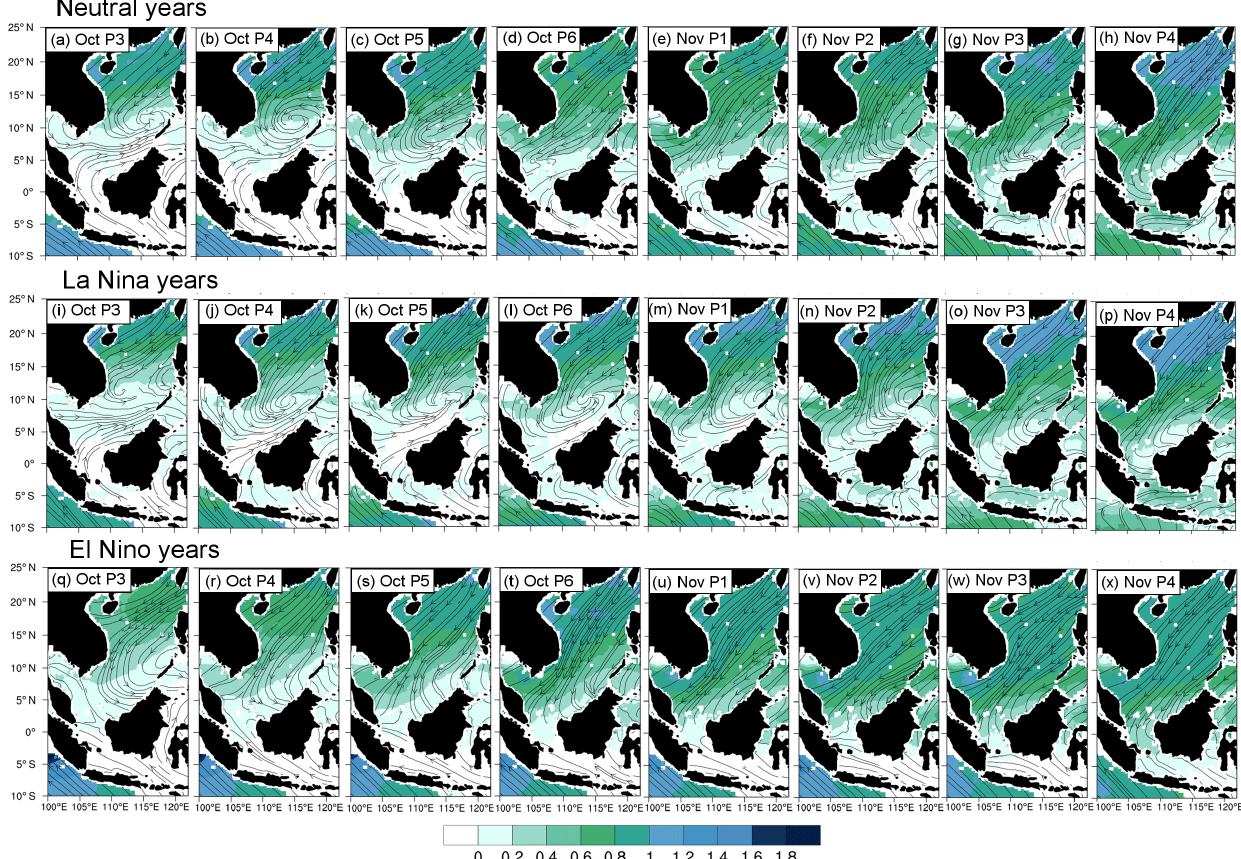
Figure 5. Like Fig. 3, but calculated from running 3-pentad mean wind, during October and November. The label indicates the central pentad. (a–h) phase-neutral years, (i–p) La Niña years, (q–x) El Niño